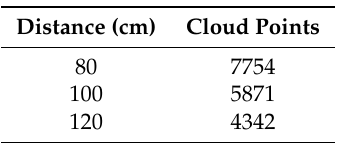
Table A2. Evaluation of the distance from the model to the frontal camera.